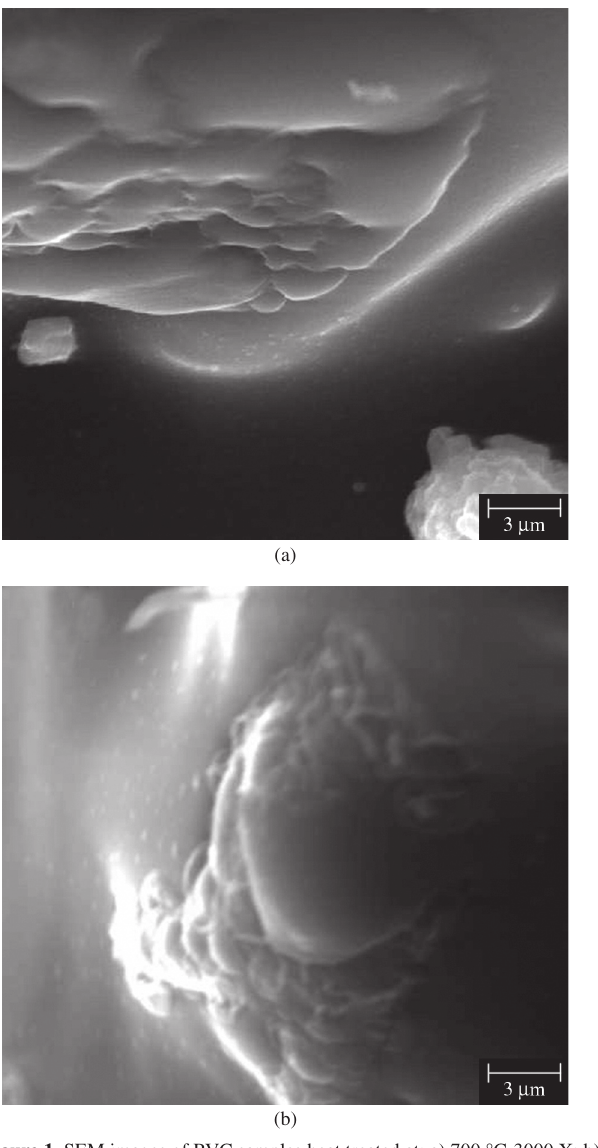
Figure 1. SEM images of RVC samples heat treated at: a) 700 °C-3000 X; b) 800 °C-3000 X; c) 800 °C-20 X; and d) 1100 °C-5000 X.